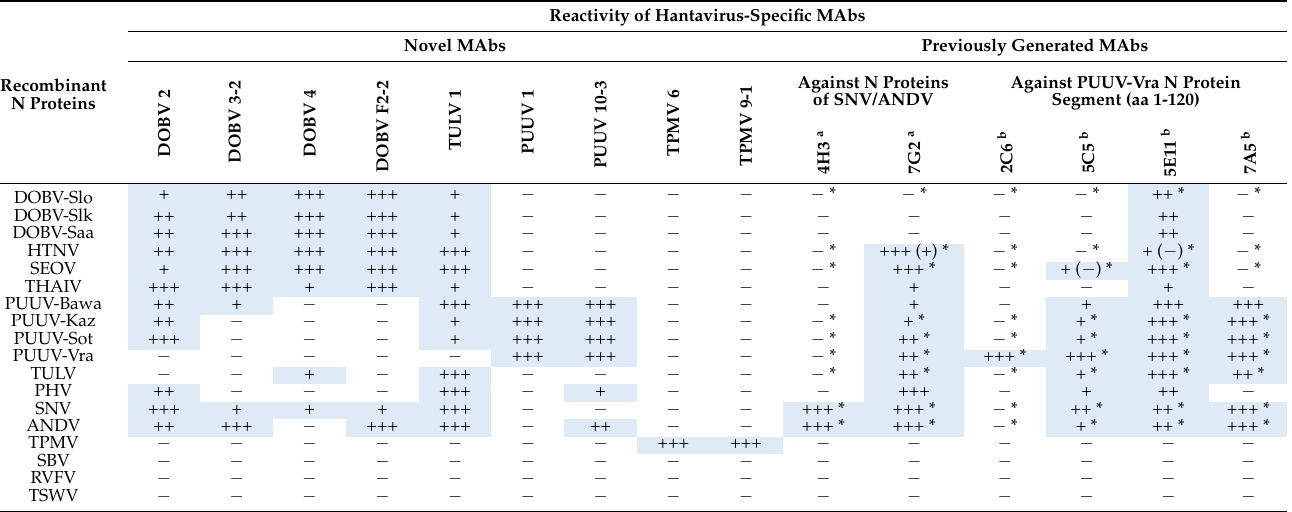
Table 2. Reactivities of hantavirus-specific MAbs with full-length hantavirus N proteins and control proteins in ELISA.